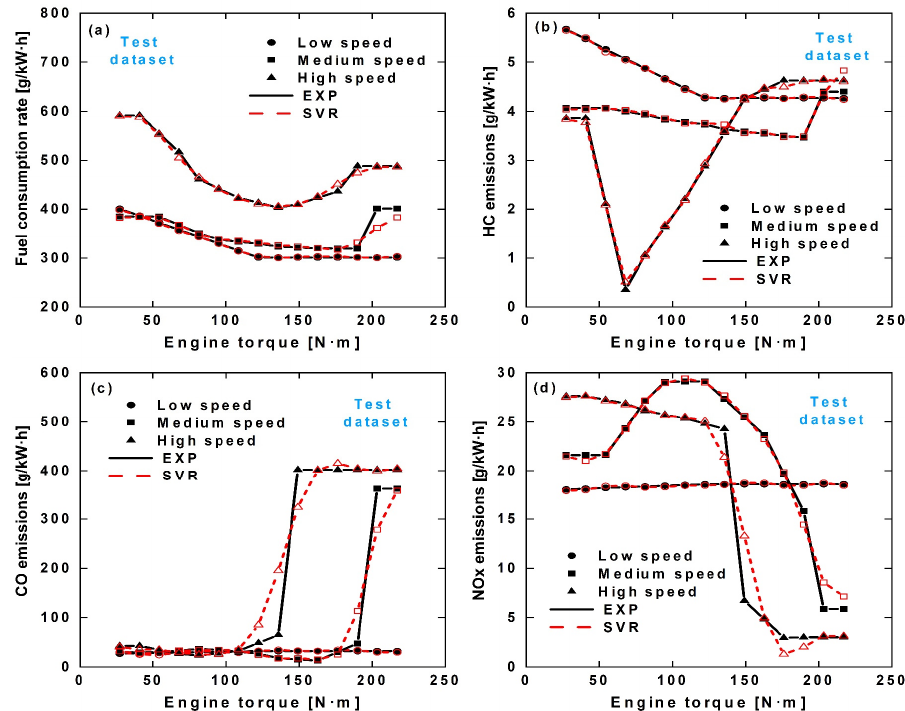
Figure 9. Comparison of SVR predicted data with experimentally measured under different engine torques. ( a ) Fuel consumption rate; ( b ) HC emissions; ( c ) CO emissions; ( d ) NO x emissions.